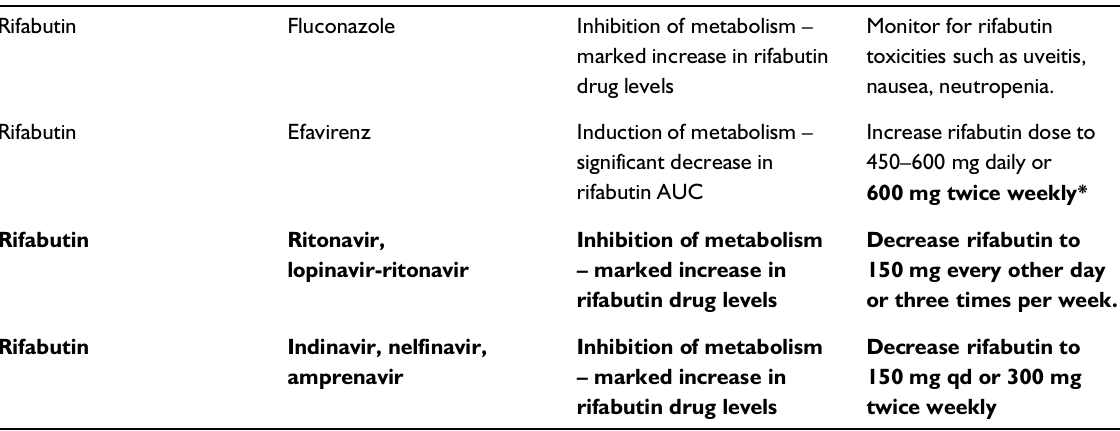
(Table 14). Recommendations advising patients how to prevent exposure to opportunistic pathogens appear in the Appendix at the end of this